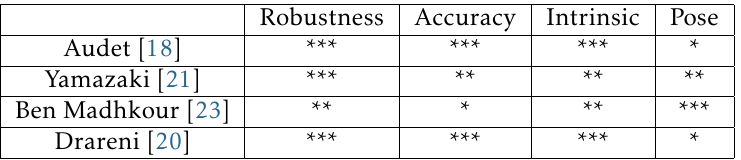
Table 2. Comparison of projector calibration methods in terms of robustness, accuracy, simplicity of intrinsic and pose